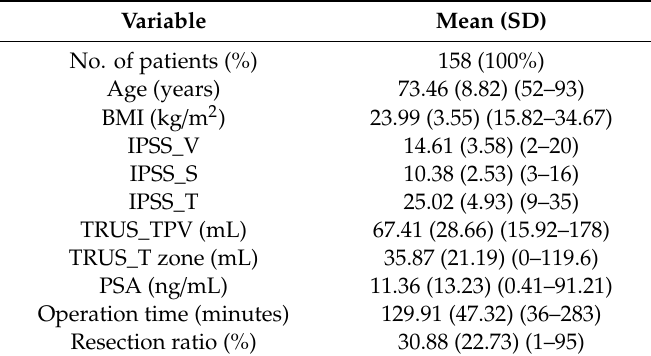
Table 1. Basic patient